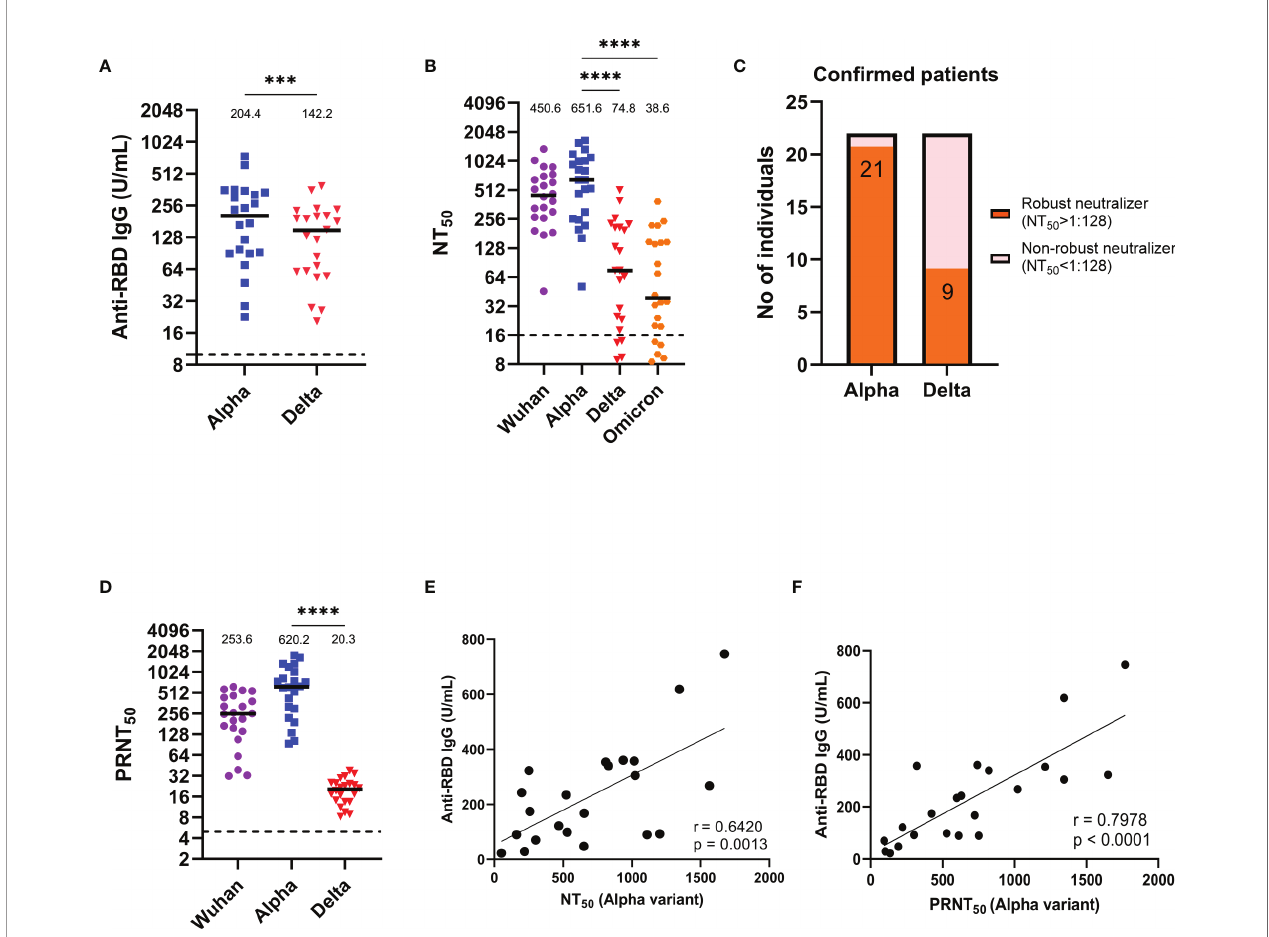
FIGURE 2 | Anti-RBD IgG titers and neutralization abilities of alpha variant infection-con fi rmed patient serum. (A) Results of an ELISA measuring serum reactivity to anti-RBD IgG (n = 22). (B) NT 50 of alpha variant infection-con fi rmed patients (n = 22) measured with indicated SARS-CoV-2 pseudovirus variants. (C) Fraction of robust neutralizers in the alpha variant infection con fi rmed patient cohort. Individuals with NT 50 above 1:128 were classi fi ed as robust neutralizers, while below 1:128 were classi fi ed as non-robust neutralizers. (D) PRNT 50 of alpha variant-con fi rmed patients (n = 22) measured with the indicated real SARS-CoV-2 variants. (E) Correlation between anti-RBD IgG titer and NT 50 . (F) Correlation between anti-RBD IgG titer and PRNT 50 . The dotted line represents the cut-off value for each assay. Duplicates were performed for each tested serum. Measured statistical signi fi cance was calculated among experiments by one-way ANOVA with Tukey ’ s multiple comparison test. Simple linear regression and Pearson correlation analysis were conducted to determine the correlation coef fi cients. Asterisks indicate statistical signi fi cance, ***p < 0.001, ****p <